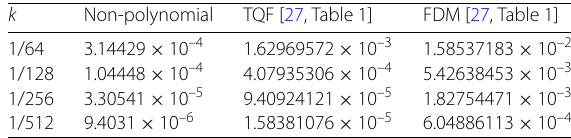
Table 13 L ∞ error norm for u ( x , t ) = v ( x , t ) of Example 2 with 0 ≤ x ≤ 3, α 1 = α 2 = 0.4, N = 5 and μ = η = 0 k TQF [27, Table 1]